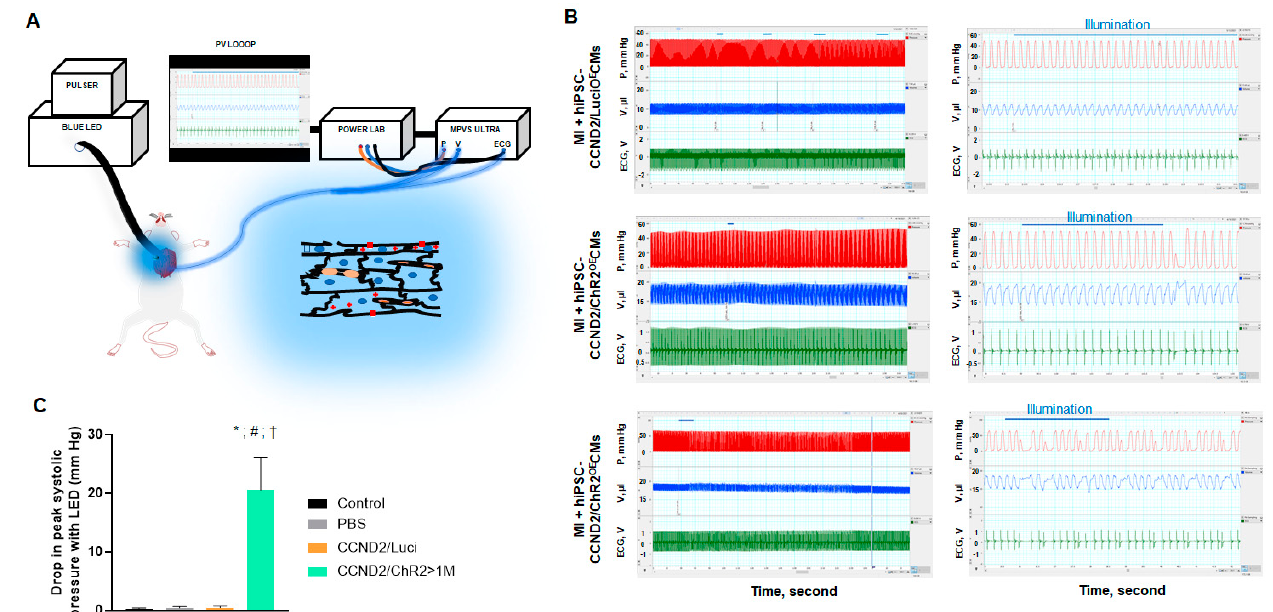
Figure 5. Light-induced changes of heart rhythm and left ventricle hemodynamics in mice. ( A ) Il- lustration of the optogenetic system. Red squares, ChR2 channels; red plus signs, membrane depo- larization; blue ellipsoids, cardiomyocyte nuclei; orange ellipsoids, capillaries. ( B ) Recordings of left ventricular pressure (red), volume (blue), and electrogram (green) in anesthetized, open-chest NOD/SCID mice 6 months after permanent coronary artery ligation and intracardiac injection of hiPSC-CCND2 OE /Luci OE CMs (upper panels) or hiPSC-CCND2 OE /ChR2 OE CMs before, during, and after blue light illumination (middle and lower panels). Center panels show tracings from the same animals on the left (boxed region) at expanded time scales. Horizontal blue lines indicate duration of blue light pulses. Premature ventricular complexes (PVC) were recorded with light illumination in mice receiving hiPSC-CCND2 OE /ChR2 OE CMs. The arrhythmic effect and decline in cardiac function were mostly transient (row 2, for 3 mice), but lasted for up to 2 min (row 3, 1 mouse). X, Y labels and values are added to improve readability, (Left) LabChart Scale 500:1, (Right) Scale 20:1. ( C ) At the onset of PVC, reduction in systolic ventricular pressure (P max ) was recorded. *— p < 0.05 versus sham control group; #— p < 0.05 versus PBS injection group; †— p < 0.05 versus CCND2 OE /Luci OE group. n = 8 mice in sham control; n = 6 mice in PBS injection group; n = 10 mice in hiPSC-CCND2 OE /Luci OE CMs group; n = 10 mice in hiPSC-CCND2 OE /ChR2 OE CMs group.